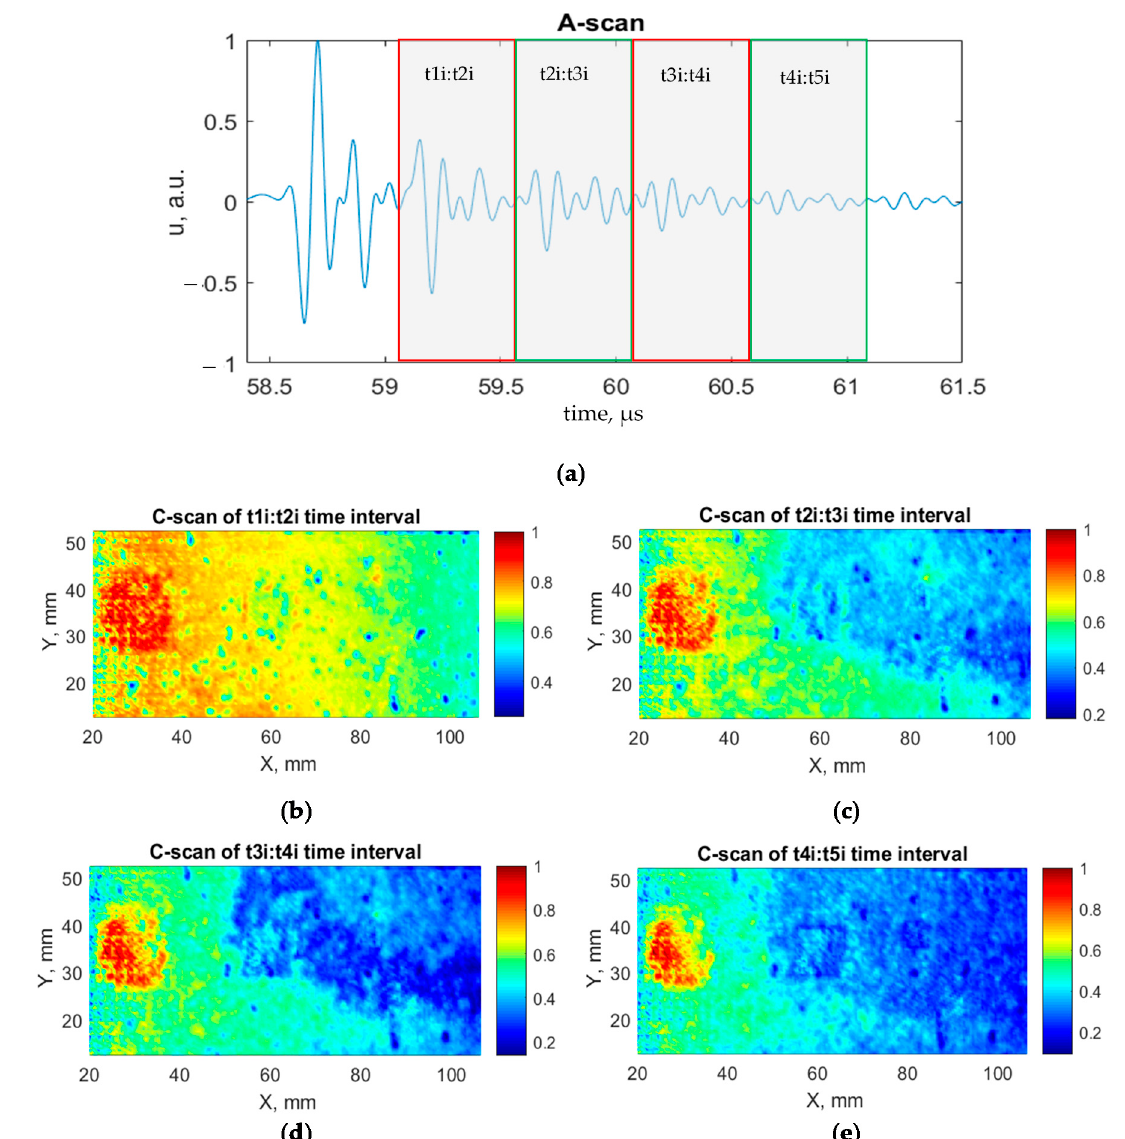
Figure 14. A-scan and C-scan of repeated interface reflections: ( a ) A-scan with indicated time intervals selected to display C-scans; ( b ) C-scan of t 1i :t 2i time interval; ( c ) C-scan of t 2i :t 3i time interval; ( d ) C-scan of t 3i :t 4i time interval; ( e ) C-scan of t 4i :t 5i time interval.